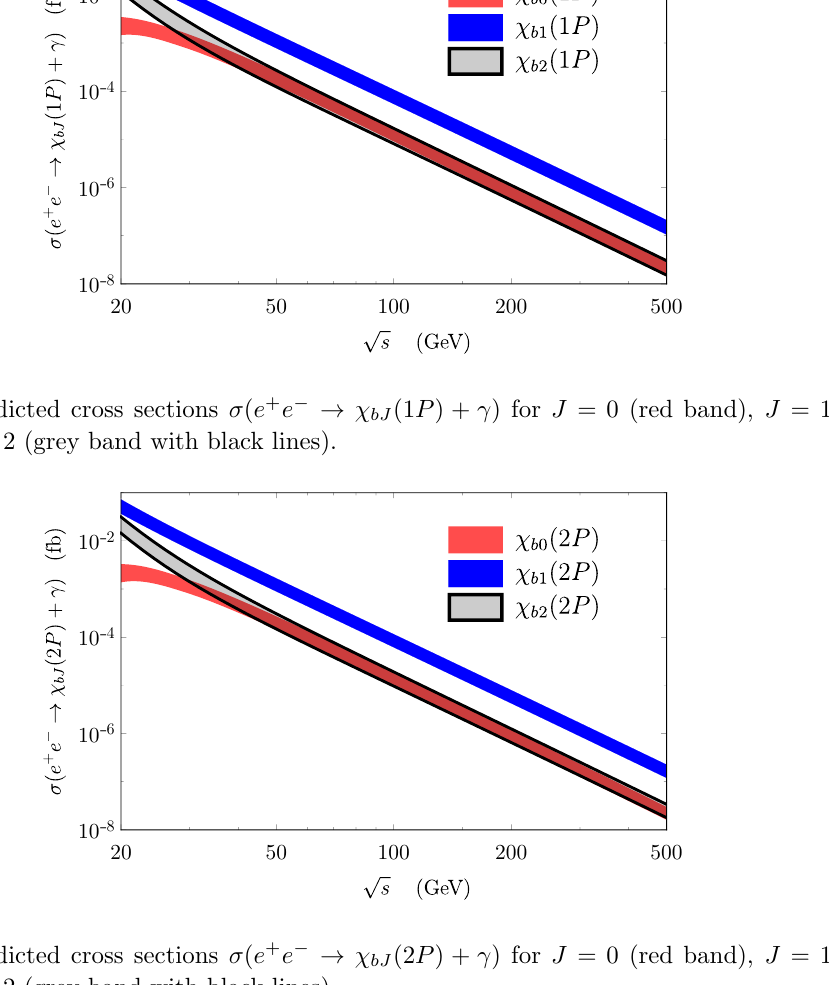
Figure 3 . Predicted cross sections (cid:27) ( e + e (cid:0) ! (cid:31) bJ (2 P ) + (cid:13) ) for J = 0 (red band), J = 1 (blue band), and J = 2 (grey band with black